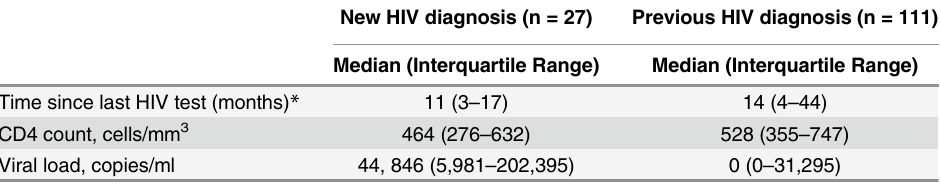
Table 2. HIV testing history, CD4 count, and VL at the time of cross-sectional survey by new and previ- ous HIV diagnosis for female sex workers, (n =